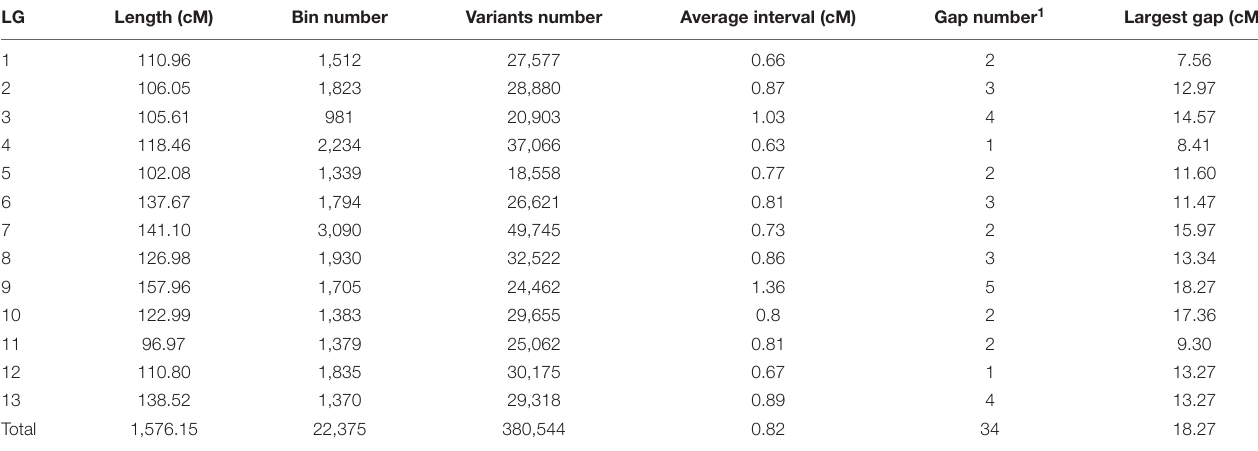
TABLE 1 | Characteristics of the superdense genetic linkage map for sesame. LG Length (cM)